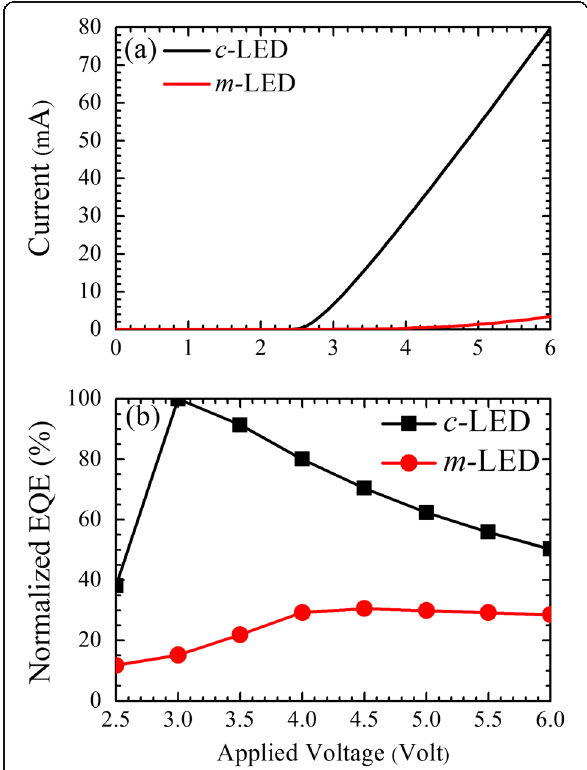
Fig. 3 a Current ( I ) and ( b ) normalized EQE as functions of applied voltage ( V ) for the c - and m